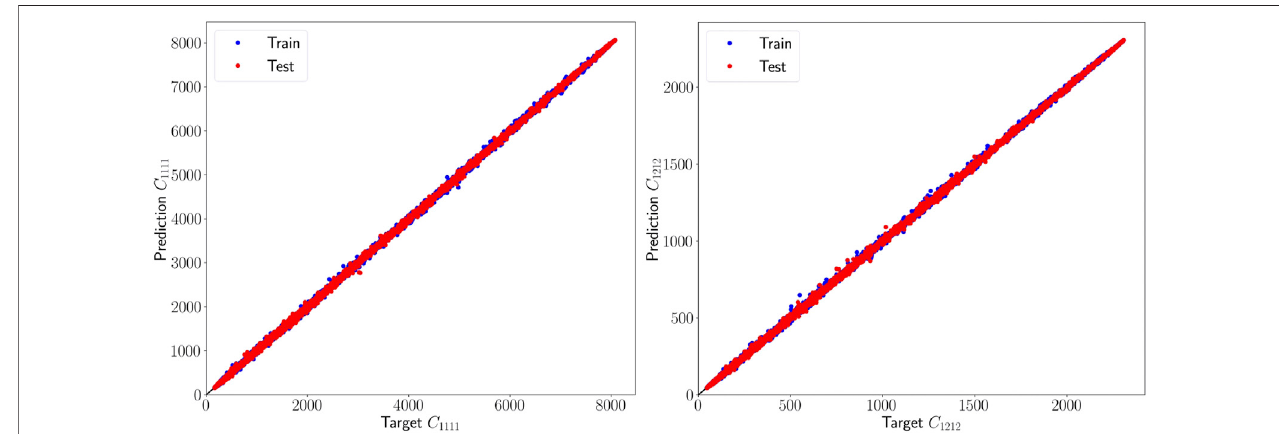
FIGURE5| Parityplotshowing theaccuracy ofModel A.Thetest points (red)are superimposed on thetrainpoints (blue). Itisseenthatboth thetrain and testsets exhibit high levels of accuracy consistent with each other.